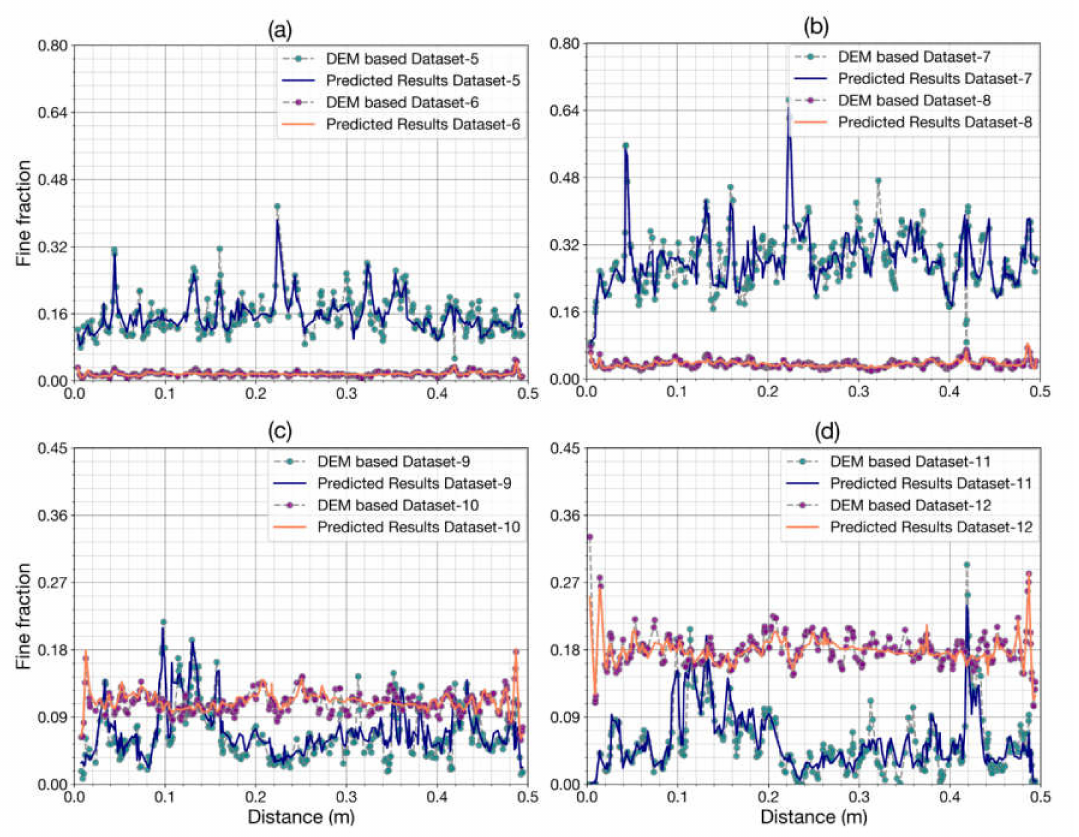
Figure 11. FNN predicted fine fraction along the flume (x-direction): ( a ) prediction for datasets 5 and 6; ( b ) prediction for datasets 7 and 8; ( c ) prediction for datasets 9 and 10; ( d ) prediction for datasets 11 and